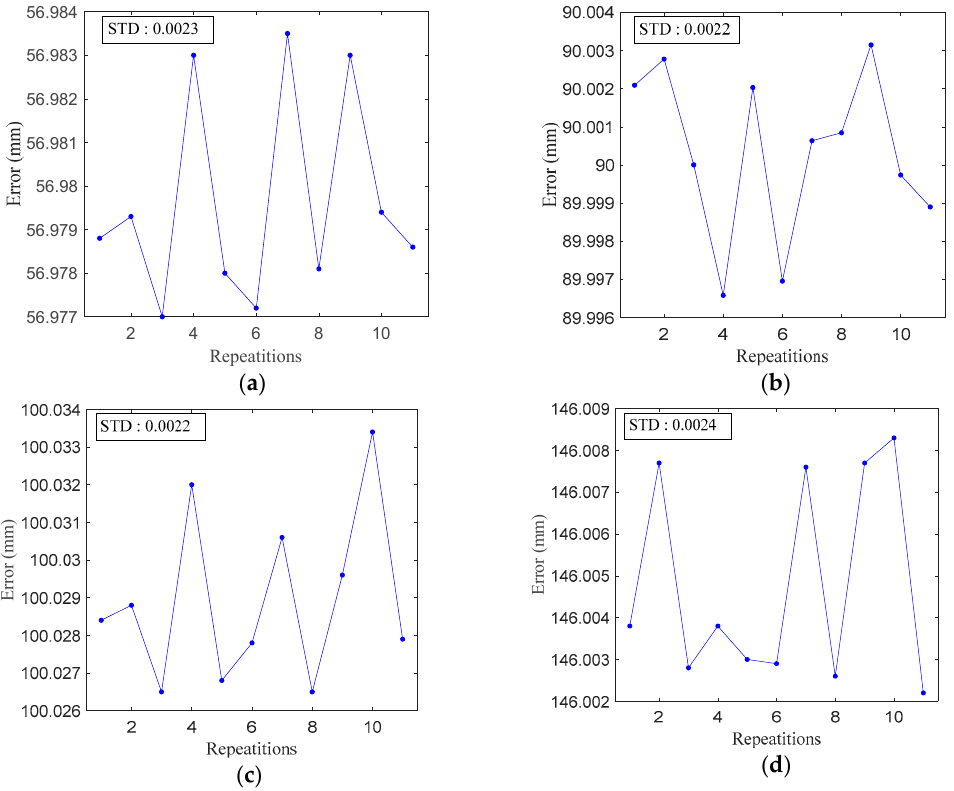
Figure 8. ( a ) Repeatability results on closer point displacement; ( b ) repeatability results on average point displacement; ( c ) repeatability results on average point displacement; ( d ) repeatability results on farther point displacement.